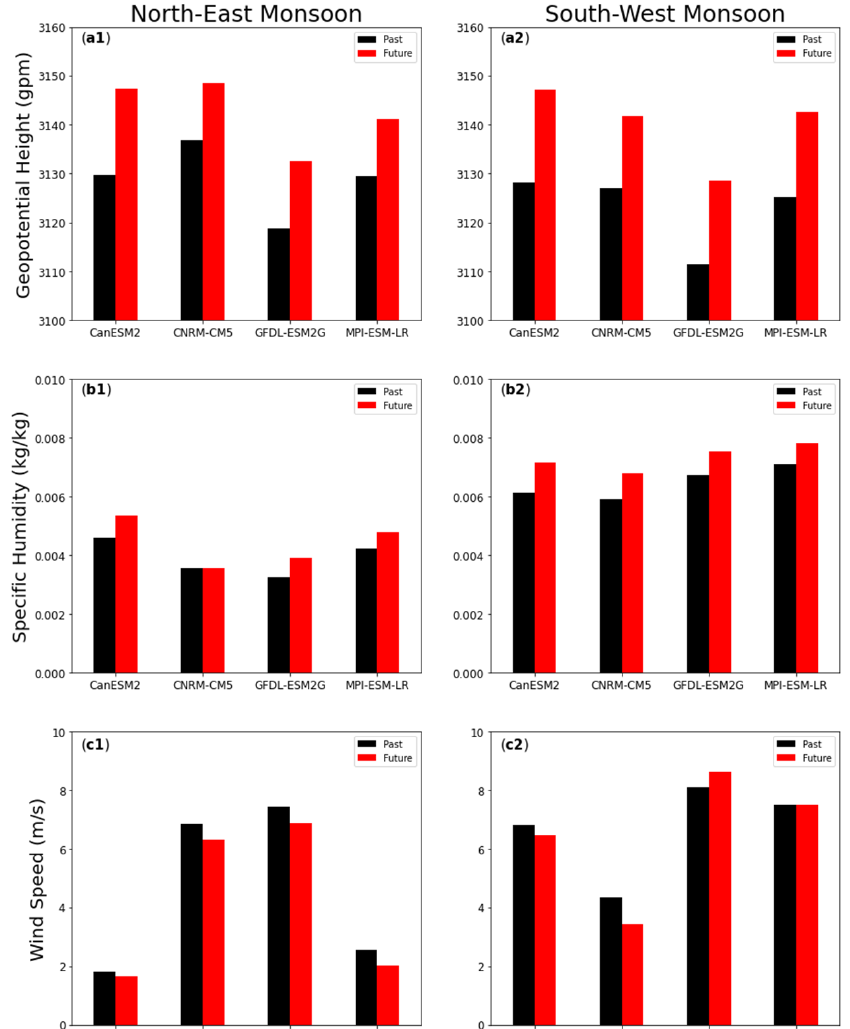
Figure 7. The comparisons of past and future climate seasonal average of variables influencing rainfall: ( a1 , 2 ) geopotential height, ( b1 , 2 ) specific humidity, and ( c1 , 2 ) wind speed.